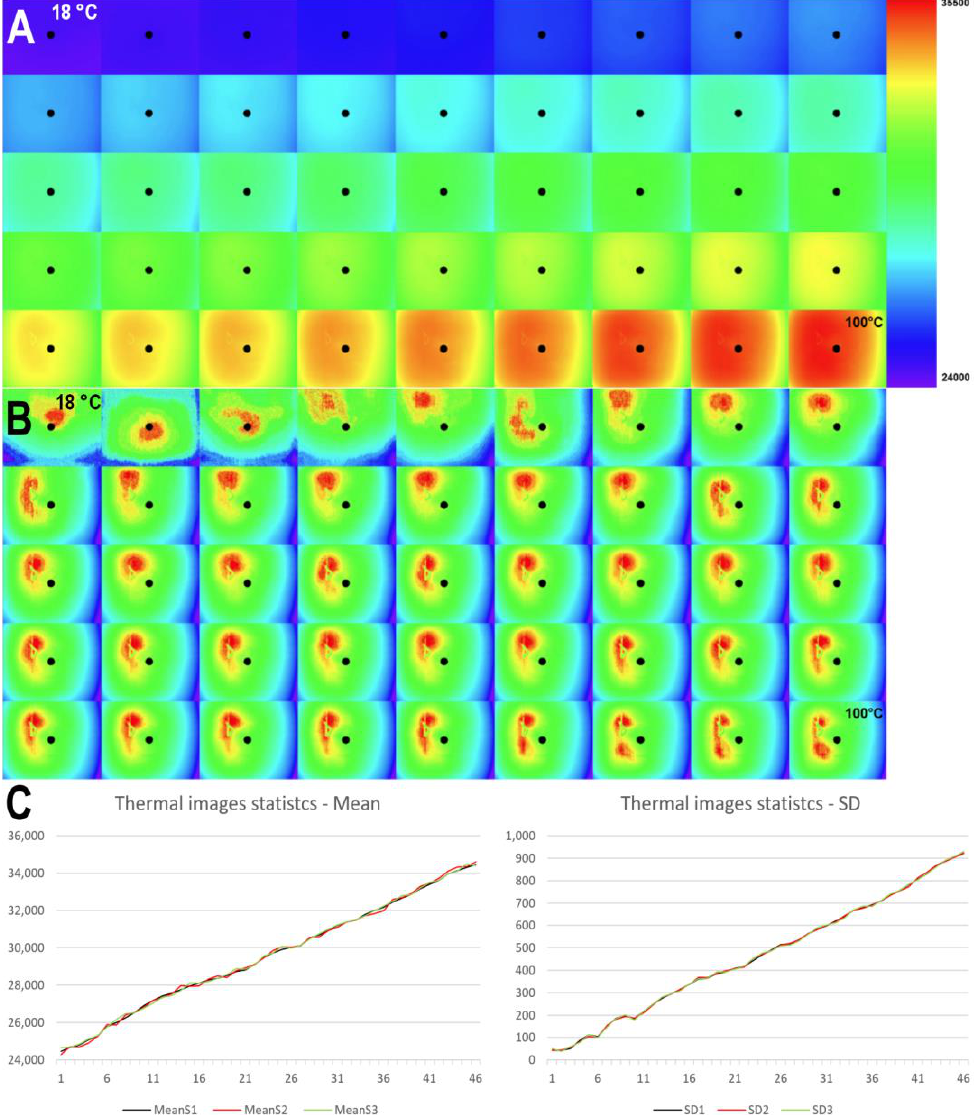
Figure 3. Radiometric calibration with the use of a 3D printer base: ( A ) thermal images recorded during the first calibration series, while heating the base of the 3D printer printout from 18 to 100 °C, arranging the images along with the temperature increase from the upper left corner to the lower right corner; in the central part, the area for which mean temperature values were calculated is marked with a black dot. DN values for all TIFF images recorded in 16-bit coding varied from 24,000 to 34,500; in this range, linear contrast stretching was used and visualization was with the same color palette. ( B ) The same thermal images with the changed method of contrast stretching to the method normalizing the shape of the histogram, separately for each image. ( C ) Graphs of image statistics, mean thermal brightness and standard deviation and their variability over time for three calibration